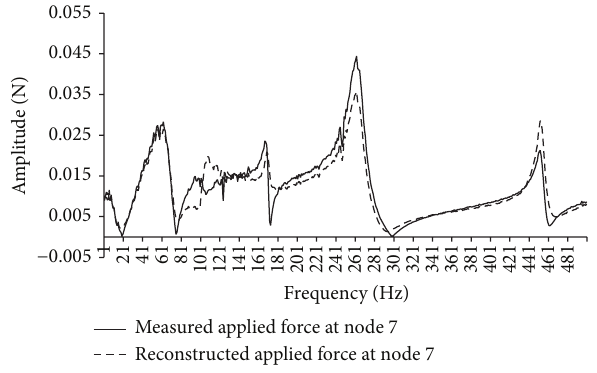
Figure 12: Experimental and estimated applied load 𝐹 7 .